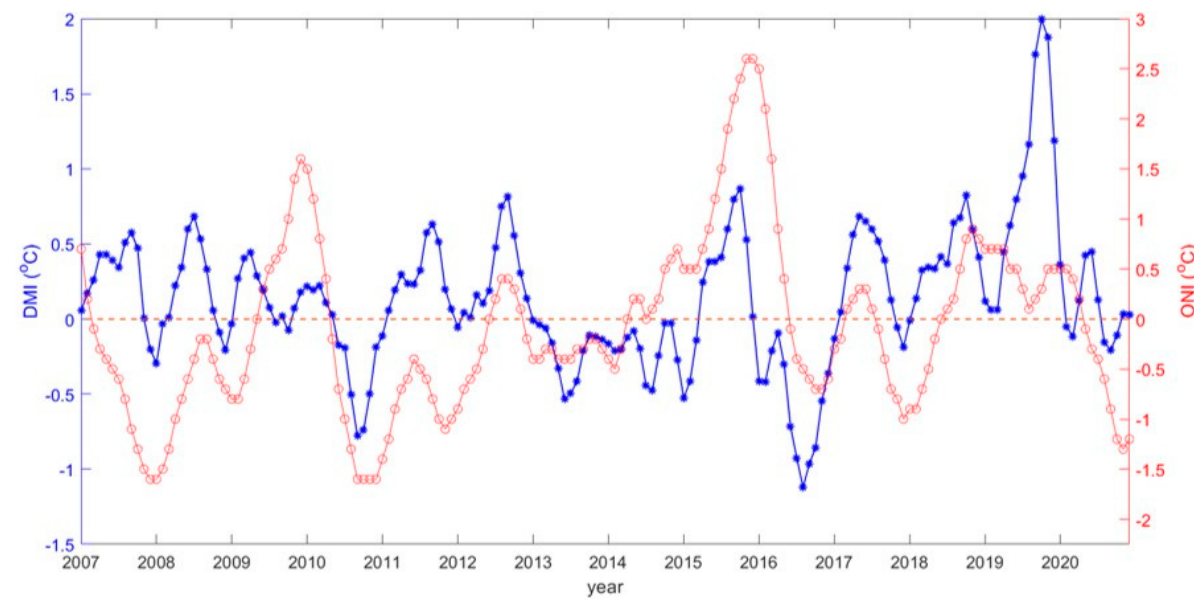
Figure 2 . Plot of Oceanic Nino Index (ONI) (red line) and Dipole Mode Index (DMI) (blue line) during 2007–2020. Table 1. El Nino-Southern Oscillation (ENSO) and Indian Ocean Dipole (IOD) years. Positive IOD